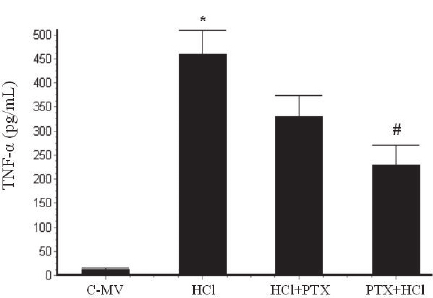
Figure 1 - Effect of pentoxifylline (PTX) on TNF-a levels in BAL from rats with mechanically ventilated controls (C-MV) and instilled with HCl. * p <0.05 versus the HCl+PTX and PTX+HCl groups, and # p<0.05 versus the HCl and the HCl+PTX groups. Values are presented as mean ± SD.